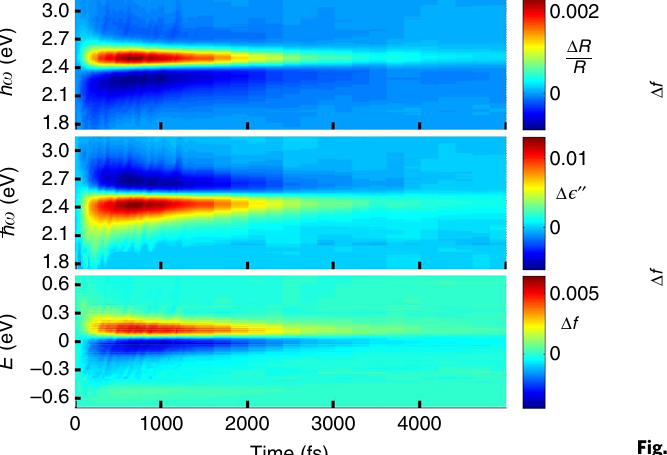
Fig. 5 Changes in carrier population for the normal incidence. a Spectrum cuts of Δ f ( E ), inferred from the second integral Eq. (4), at t = 70, 150, 250, 500fs. The relatively broad initial electron energy distribution change at the earlier time (70fs) evolves to a narrower and larger magnitude Fermi – Dirac distribution at later time (500fs). b Same as a but with multiplication factors in order to better compare the various time functional a Fermi – Dirac distribution at an elevated temperature relative to